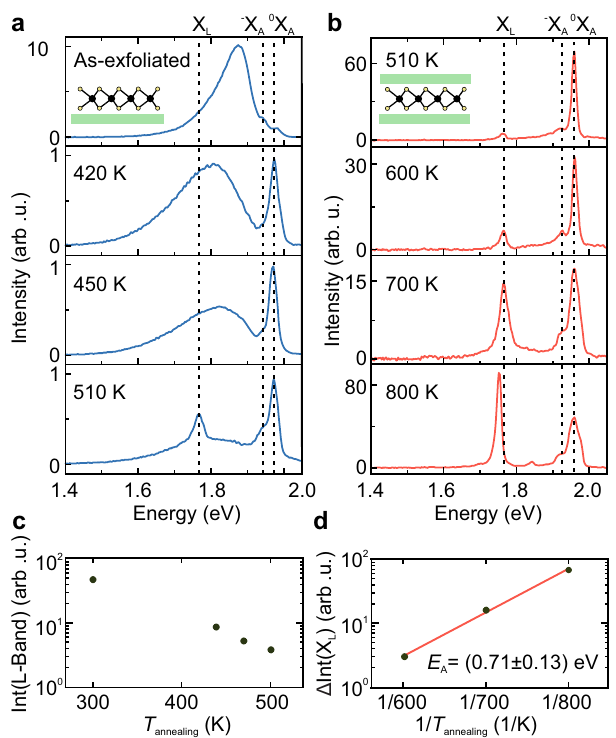
Fig. 2 Evolution of MoS 2 low-temperature PL with increasing annealing temperature. a Compared to as-exfoliated MoS 2 on hBN (top panel) the broad L-band is strongly reduced after successive mild annealing. At 510 K, an emission line X L appears at 1.75 eV (bottom panel). The spectra were normalized to the intensity of the exciton to highlight relative changes between the L-band, the trion and the free exciton emission. b PL spectra of fully encapsulated MoS 2 . With increasing annealing temperature, the intensity of X L increases. Dashed lines highlight neutral exciton ( 0 X A ), trion ( − X A ), and X L . The spectra are presented as measured without further normalization. c Integrated intensity of the L-band in a as function of annealing temperature. The change in L-band emission is related to the desorption rate of adsorbates from the MoS 2 . d Arrhenius plot of thermal defect generation rate extracted from the change in intensity of X L between subsequent annealing steps, which is denoted as Δ Int(X L ). The activation barrier E A extracted from the fi t (red line) is (0.71 ± 0.13) eV consistent with formation of sulfur